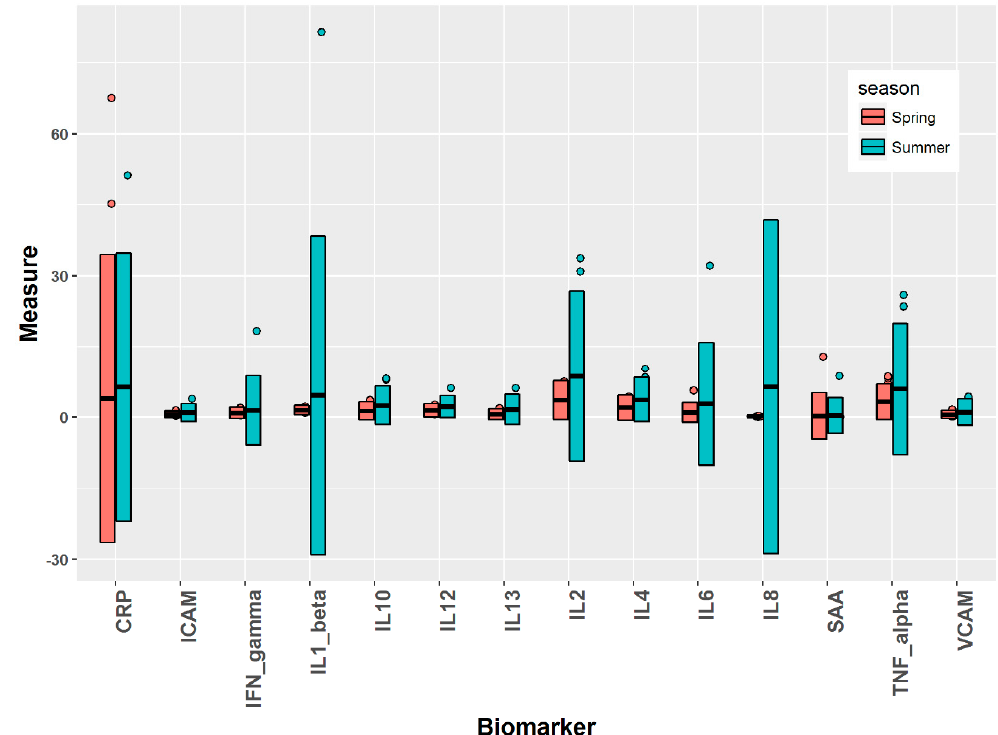
Figure 1. Concentrations of biomarkers during spring and summer seasons, 2014. CRP, SAA, ICAM-1, and VCAM-1 are shown in μ g/mL; IFN- γ , IL1- β , IL-2, Il-4, IL-6, IL-8, IL-10, IL-12, IL-13, and TNF- α are given in pg/mL. In the figure, the central line across the box represents the mean, and the upper and lower boundaries correspond to three standard deviations above and below the mean, respectively. The outliers falling outside three standards of the mean are marked with circles. For ease of illustration, four biomarkers are rescaled: IL-4 upscaled by a factor of 10; SAA and IFN- γ downscaled by a factor of 1/20; IL-8 downscaled by a factor of